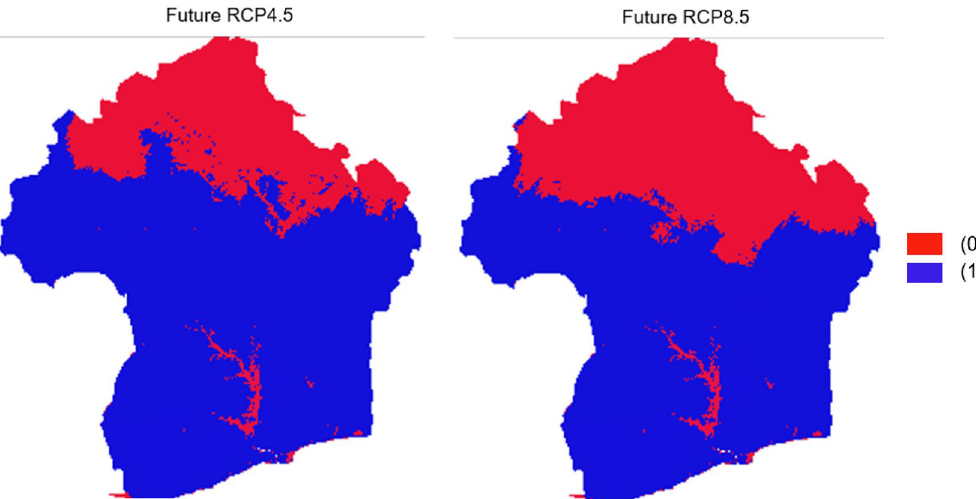
Figure 9. Output of the mobility-oriented parity analysis of KG from ‘ntbox’; 0 (Red) represents strict extrapolation areas meaning complete dissimilarity between calibration environments and extrapolation regions in the future; 1 (Blue) area similar to areas where the models have been calibrated. Software used: ArcGIS v.